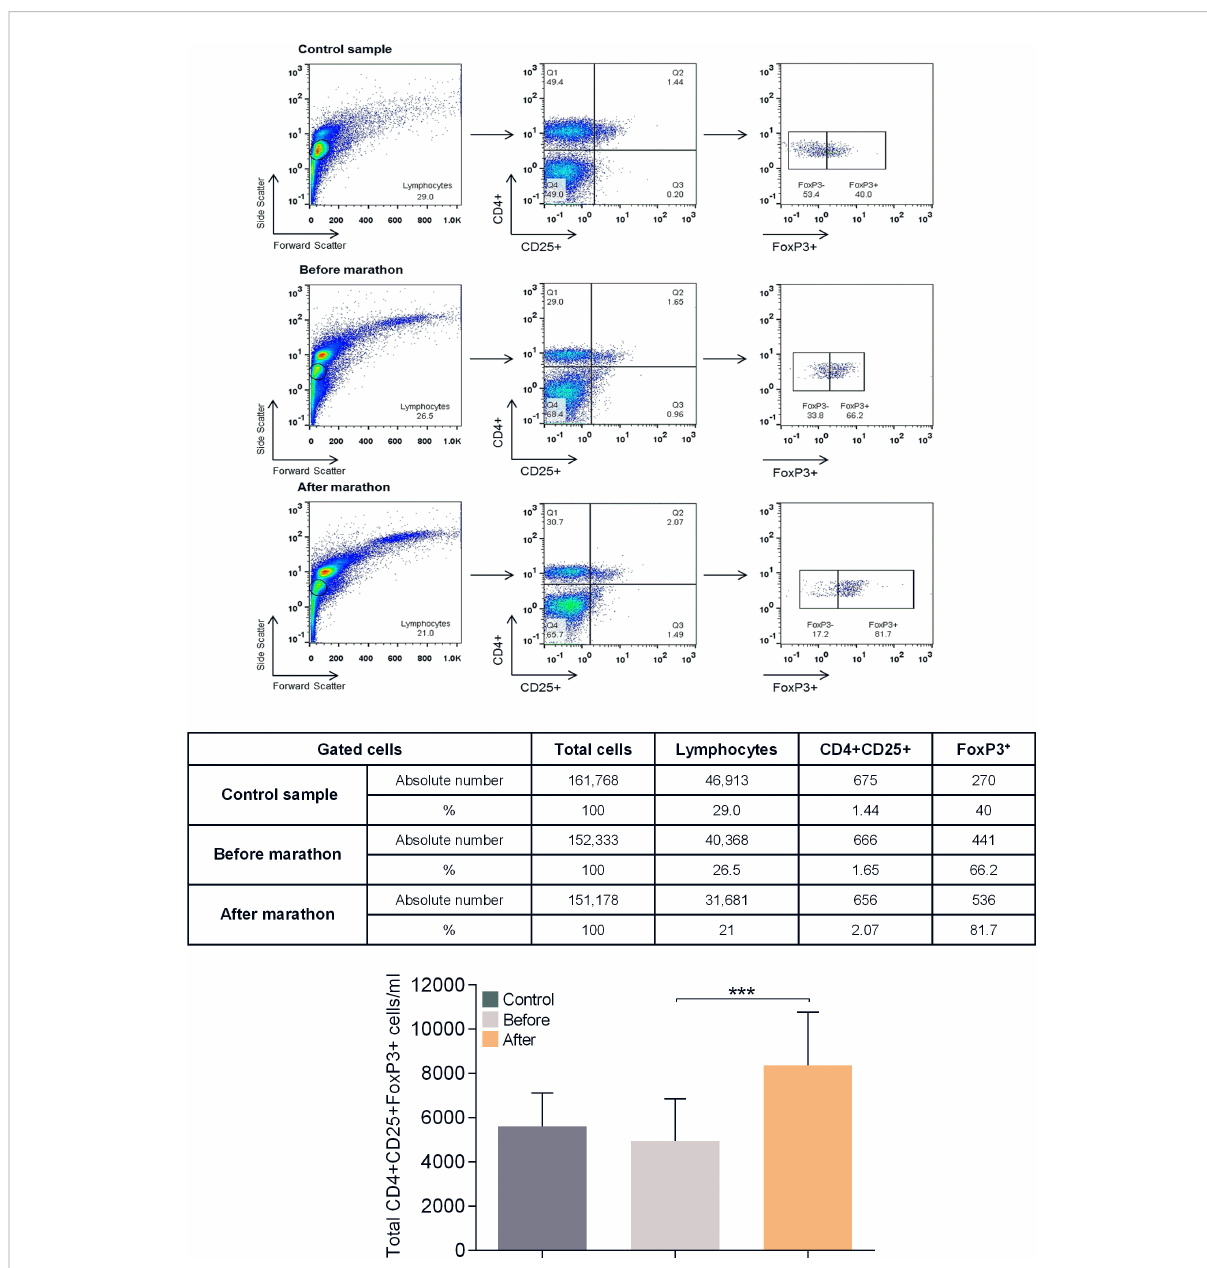
FIGURE 3 Flow cytometric analysis for determination of CD4+CD25 high FoxP3+ Treg levels in human peripheral blood. Shown is a representative analysis for a control and a marathon runner before and after the race. Leukocytes were gated for lymphocytes using forward and side light scatter and analyzed for CD4 and CD25 expression. The double positive cells were additionally analyzed for FoxP3 expression. The numbers in the dot plots indicate the percentage of gated cells expressing the relevant marker. The table below shows the absolute number of cells in each population analyzed. Bottom graph: Results of the analysis of all study participants (control values are shown in dark gray, values of marathon runners before the race are shown in light gray, values of marathon runners after the race are shown in orange). Data are shown as mean (SD);